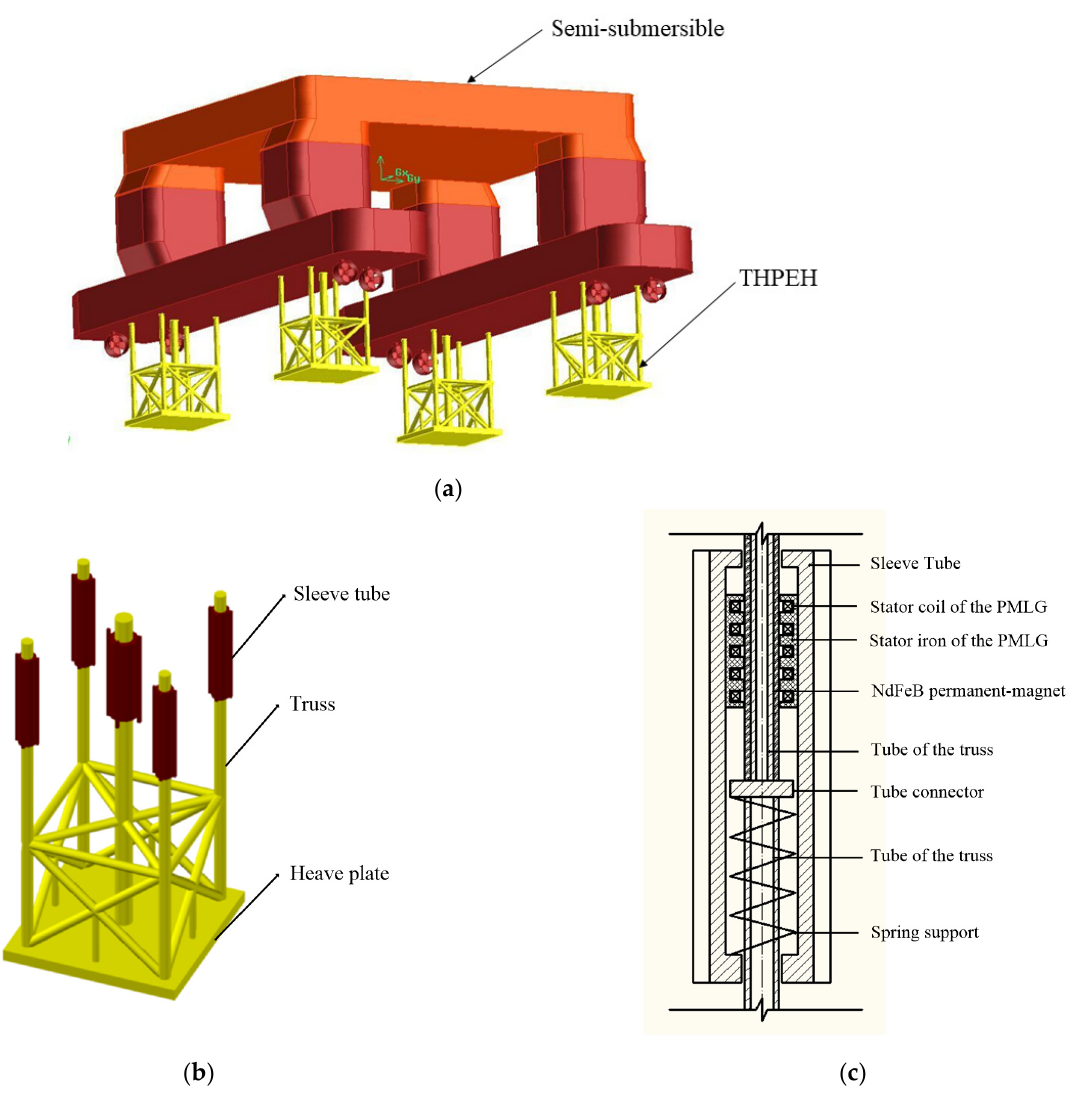
Figure 1. The conceptual design of the THPEH: ( a ) An illustration of the semi-submersible platform with the THPEH; ( b ) An illustration of a truss–plate structure of the THPEH; ( c ) A diagram of the connection structure in the sleeve